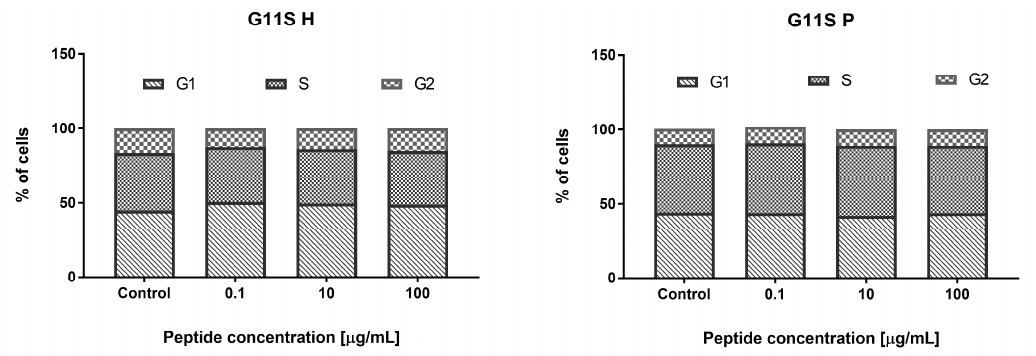
Figure 6. The effect of G11S H and G11S P on the cell cycle phases.